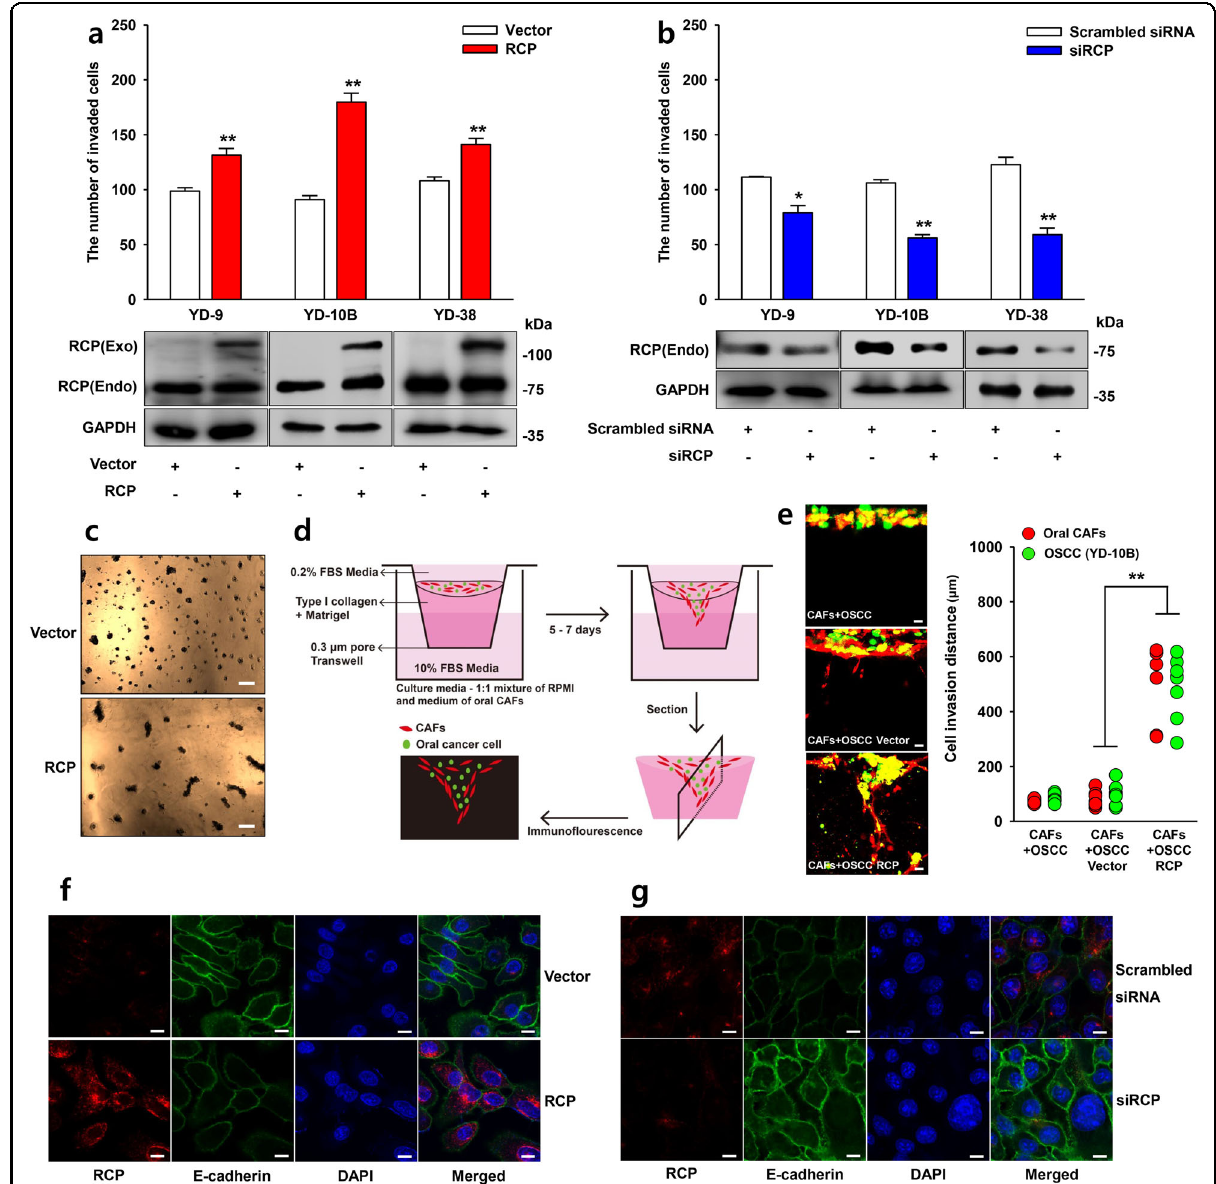
Fig. 1 RCP induces OSCC EMT and invasiveness. a , b OSCC cells were transfected with the indicated vectors or siRNAs. Cell invasion assays were performed with media without any attractant as the control (error bars, ±SD: *** p < 0.001 and ** p < 0.01 vs control). c 3D Matrigel culture showing the growth of transfected YD-10B cells with vector or RCP. Image original magni fi cation ×40, scale bar, 200 μ m. d Schematic drawing showing the coculture of CAFs and OSCC cells in the 3D Matrigel invasion system. YD-10B cells were transfected with vector or RCP. CAFs, and YD-10B cells were labeled with staining dye (CAFs: red, YD-10B: green) and then incubated for 7 days for 3D gel invasion analysis. The gel was sectioned without fi xation, and then the cells were analyzed by fl uorescence confocal microscopy. e Compared to the vector control, RCP overexpression enhanced OSCC cell invasive potential when cocultured with oral CAFs. In these images, the distance of invaded cells was measured in eight different positions and calculated by the ZEN blue edition program of Carl Zeiss Microscopy GmbH. Image original magni fi cation, ×50, scale bar, 50 μ m. f , g The cells were transfected with the indicated vectors or siRNAs, and the expression of E-cadherin was visualized by fl orescence confocal microscopy. Image original magni fi cation, ×600, scale bar, 10 μ m. The results shown are representative of three experiments with similar results and indicate the mean ± SD of three